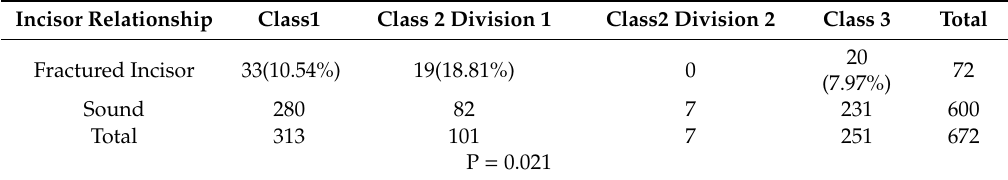
Table 2. Relationship between malocclusion and fractured incisor.